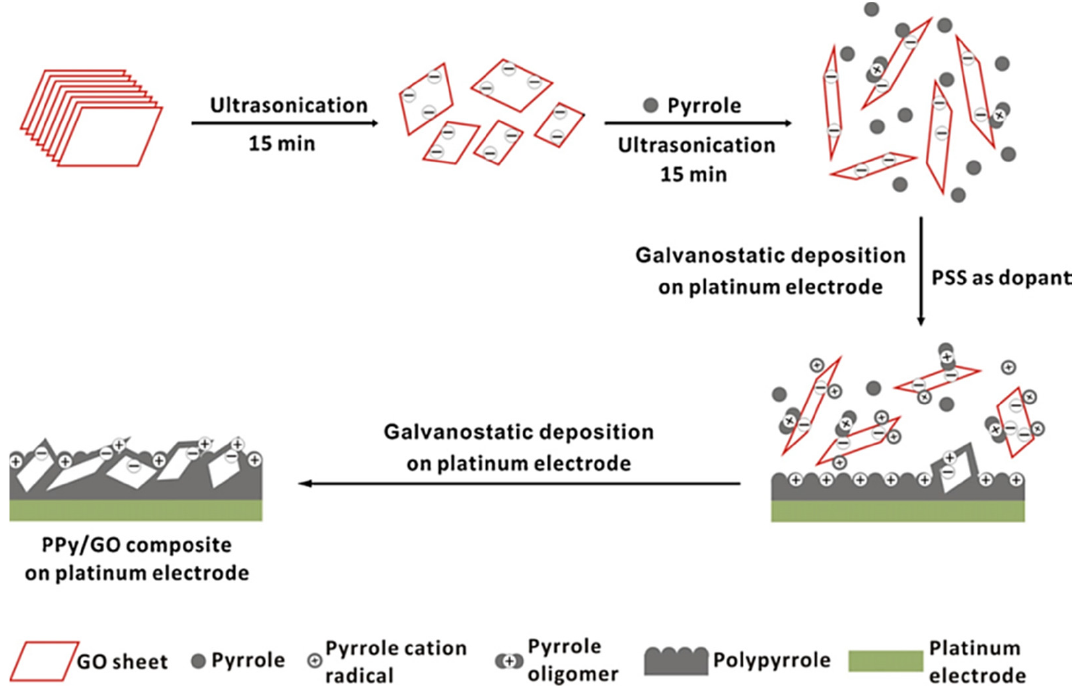
Figure 5. Electrochemical deposition of PPy/GO coating on the Pt electrode site [82]. PPy/GO = polypyrrole/graphene oxide; Pt = platinum.